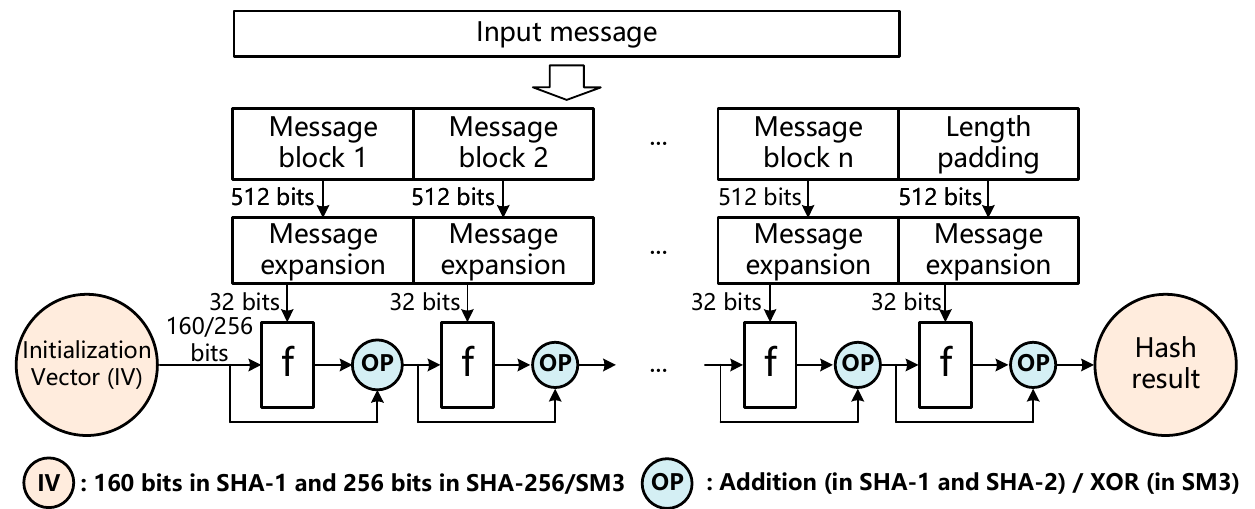
Figure 3. Merkle–Damgård construction of hash functions.